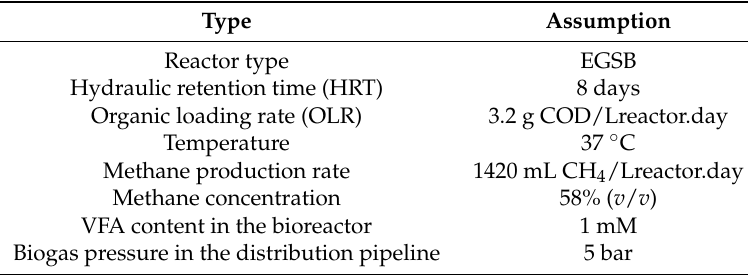
Table 2. Technical values used for simulation of the fungus scenario 1 .